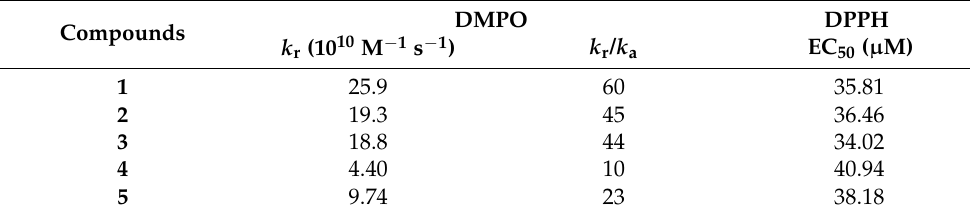
Figure 6. Radical scavenging: ( a ) EPR spectra of DPPH (100 µM) with increasing amounts of the indicated compound. ( b ) Comparison of the DPPH radical scavenging activity of the compounds. The DPPH concentration was 100 µM and the concentration of the test compound increased from 2 to 90 µM. The corresponding EC 50 values are indicated in Table 2. Table 2. Antioxidant properties of the test